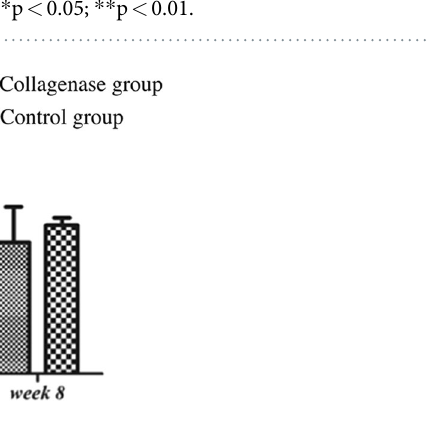
Figure 4. The static weight bearing ratio of the injured hindlimbs. * Compared with the Shane Controls; ** p <